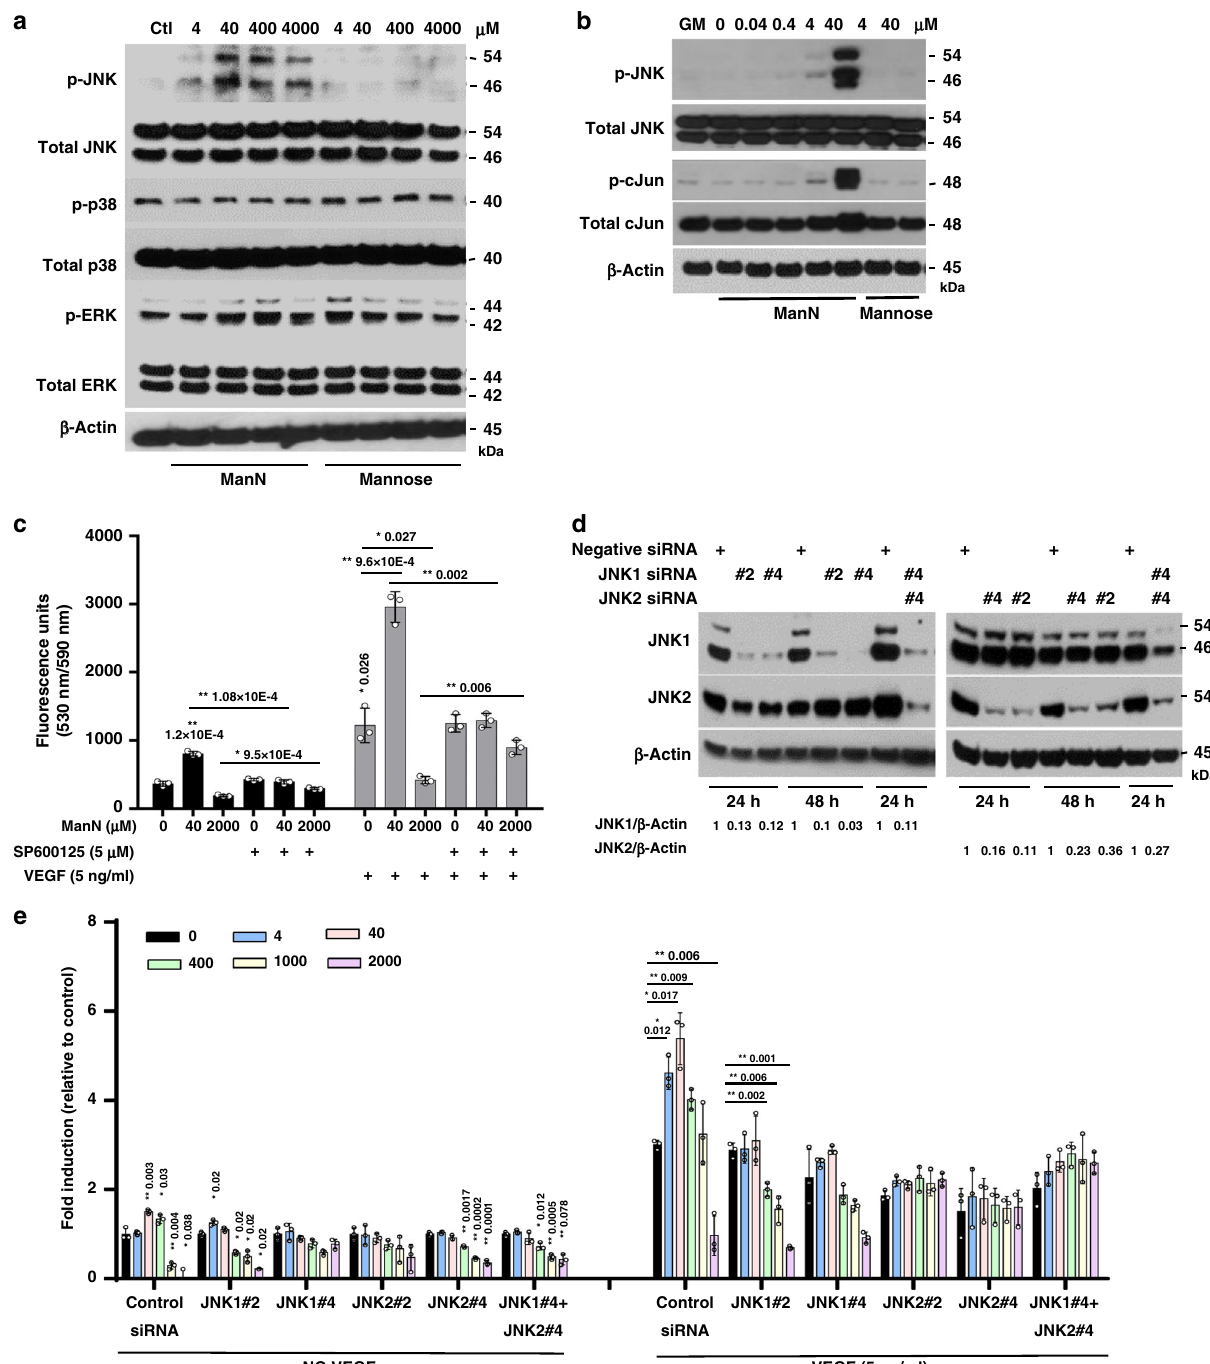
maturation pathway. This enzyme has been used to screen for potential N-glycosylation inhibitors 23 . ManN, but not other hexosamines or their derivatives, showed inhibitory activity at 400 μ M (Supplementary Fig. 9a), which is considerably higher than the effective mitogenic concentrations in BCECs. No effect of ManN up to 2 mM on α - or β -glucosidases was detected (Supplementary Fig. 9b, c). N-linked glycans from BCECs were isolated by enzymatic cleavage, followed by puri fi cation and characterization using MALDI-TOF-MS. Treatment with 40 μ M ManN resulted in a signi fi cant time-dependent reduction in Man6GlcNAc2 (Man-6), Man-8, and Man-9 in total oligomannose N-glycan